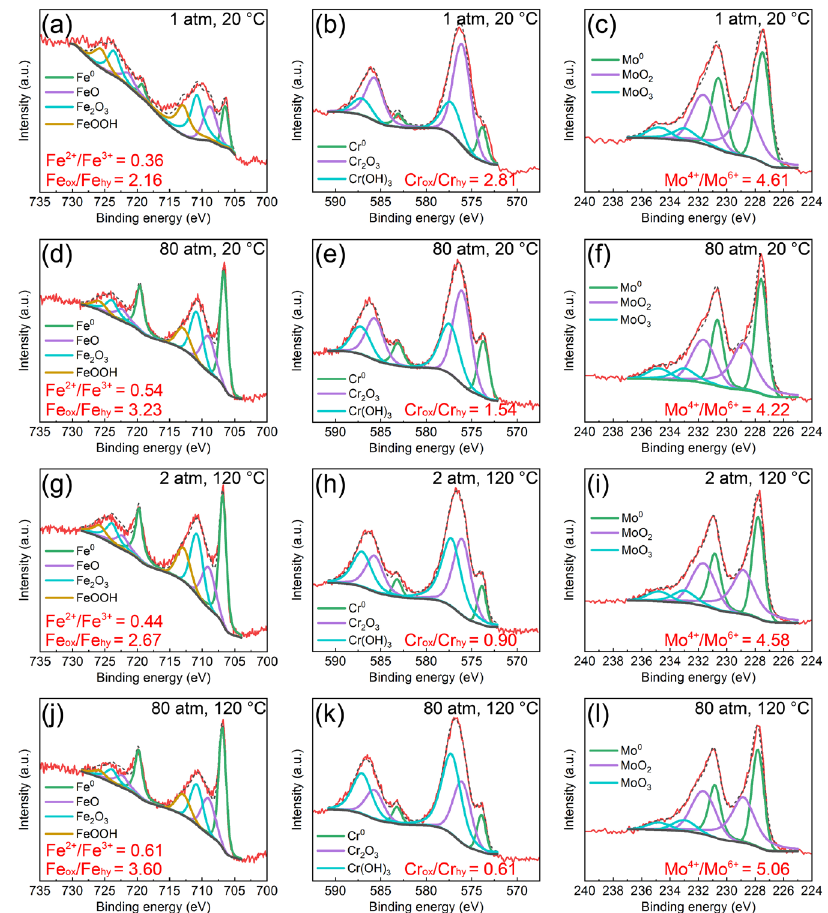
Figure 6. Fe 3p, Cr 3p and Mo 4d spectra for the AMCs after 10-day immersion in 3 wt.% KCl solution under different temperatures and pressures: ( a – c ) 1 atm and 20 °C, ( d – f ) 80 atm and 20 °C, ( g – i ) 2 atm and 120 °C, ( j – l ) 80 atm and 120 °C.